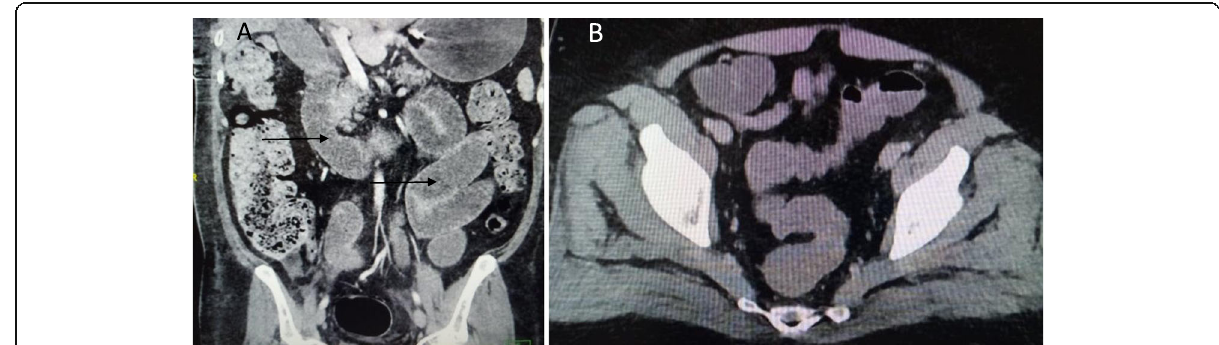
Fig. 7 a Fluid-filled small bowel loops (arrows) in a 44-year-old confirmed COVID-19 male patient, isolated in the medical ward. b Another 58-year-old male patient isolated in the medical ward then presented with a history of diarrhea; MDCT study shows fluid- filled rectosigmoid colon